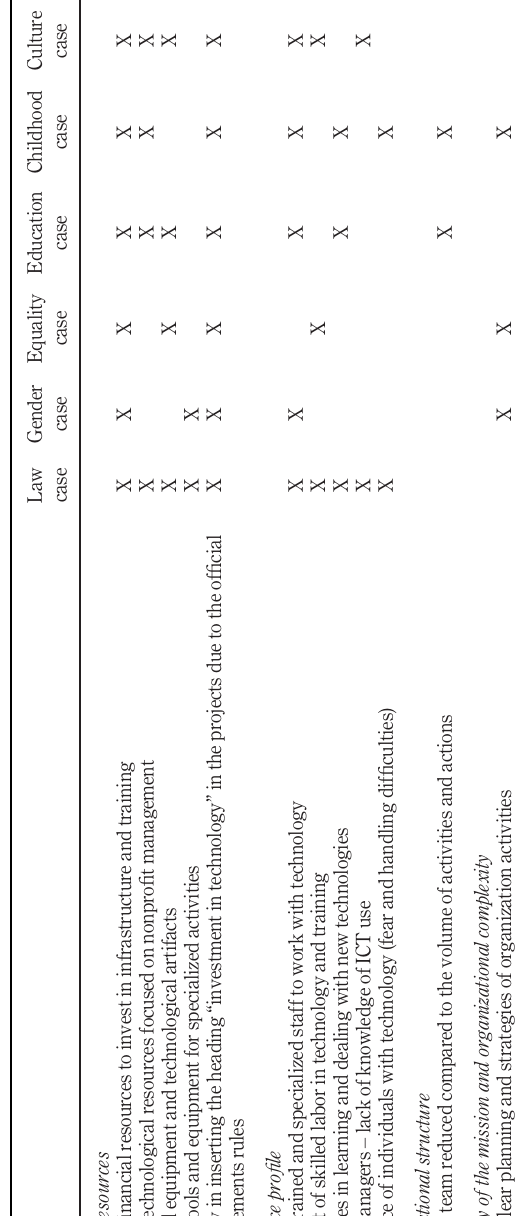
Table VI. Barriers to the actualization of the affordances in the investigated